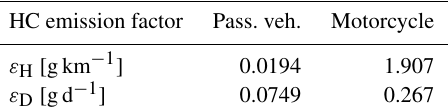
Table A4. Aggregated HC emission factors for busses and passenger vehicles for HBEFA 3.3 for